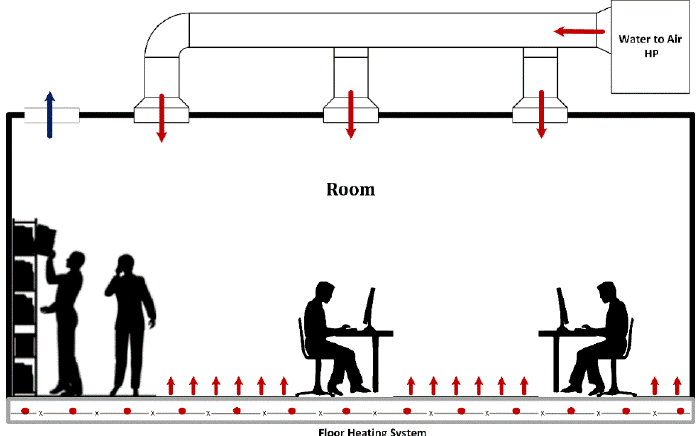
Figure 10. Schematic of the office zone equipped with hydronic radiant floor and convective systems.